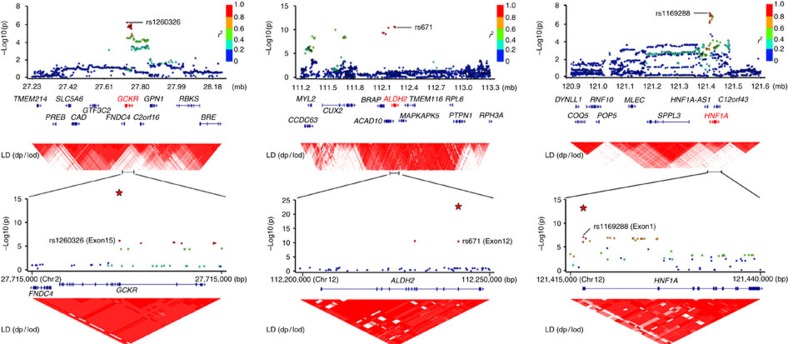
Regional plots of the three regions significantly associated with the serum AAT levels.The chromosomal positions and P values for SNPs in the three significant regions are shown accordingly. Brightness of the red colour in LD blocks corresponds to the strength of LD. The red stars in the lower panels represent the associations in the combined study (n=9,359).